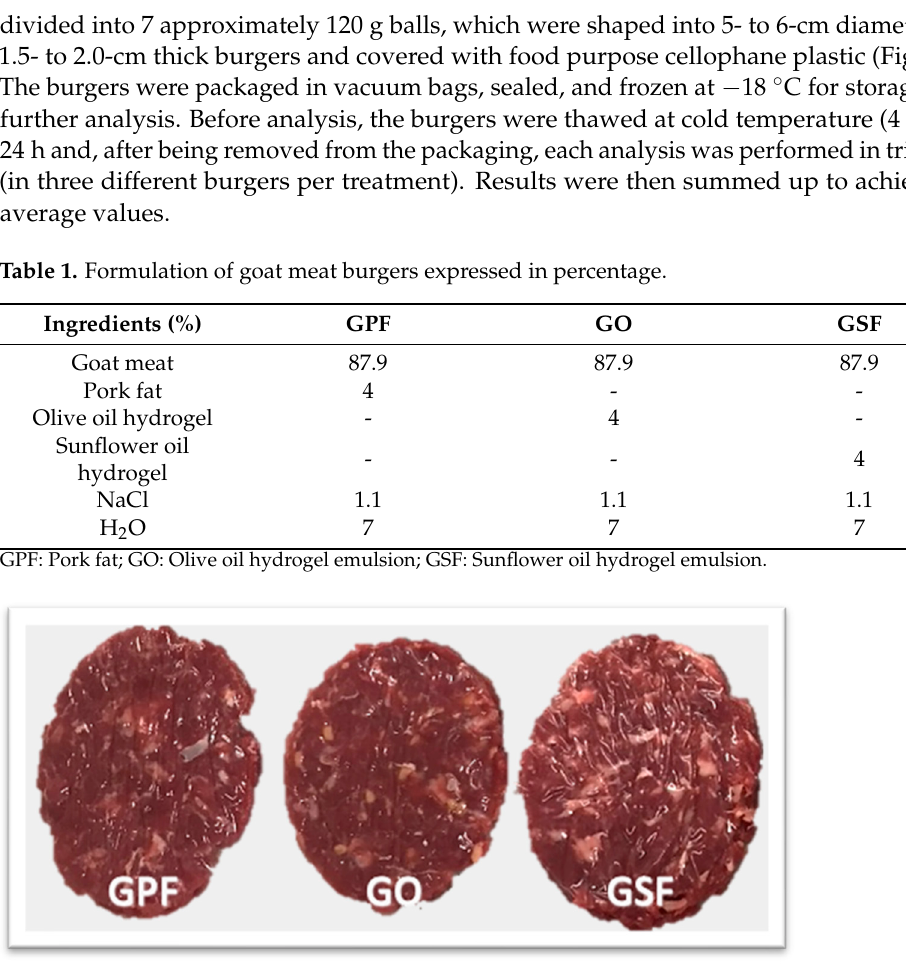
Table 1. Formulation of goat meat burgers expressed in percentage .